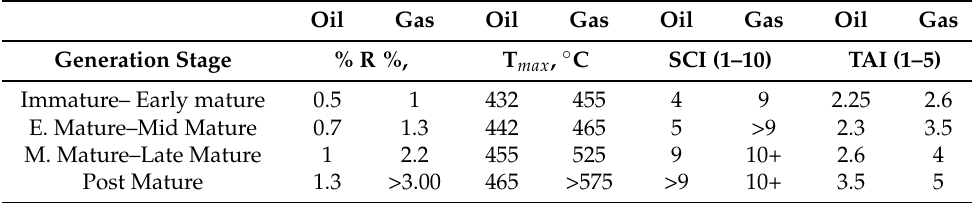
Table 3. Equivalence maturity parameters with respect to oil and gas generation